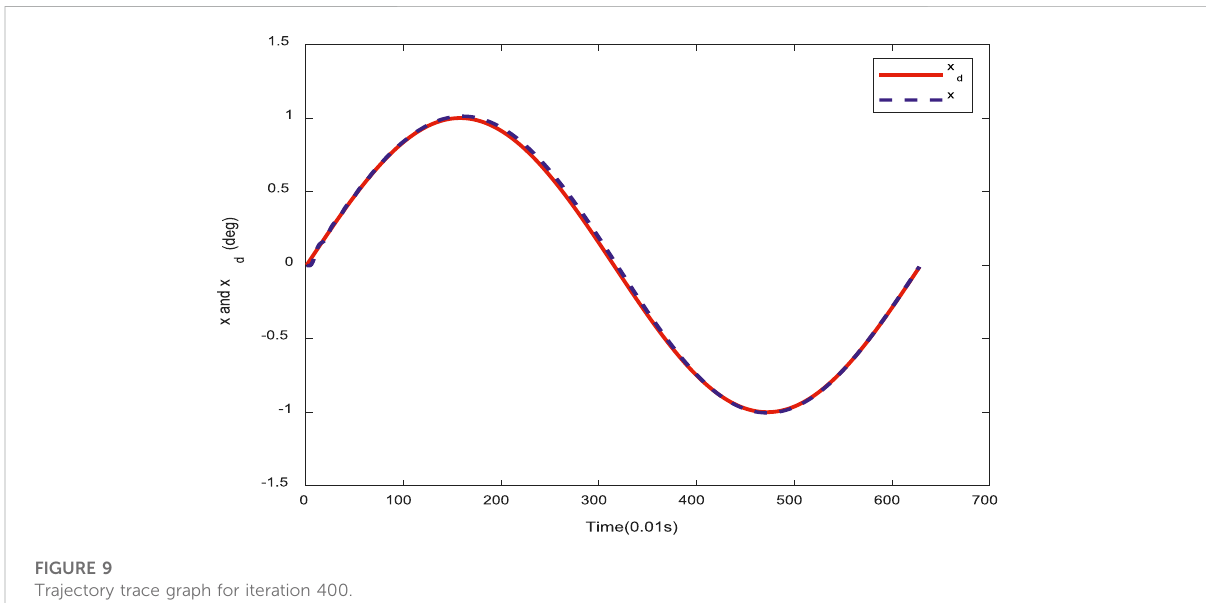
FIGURE 9 Trajectory trace graph for iteration